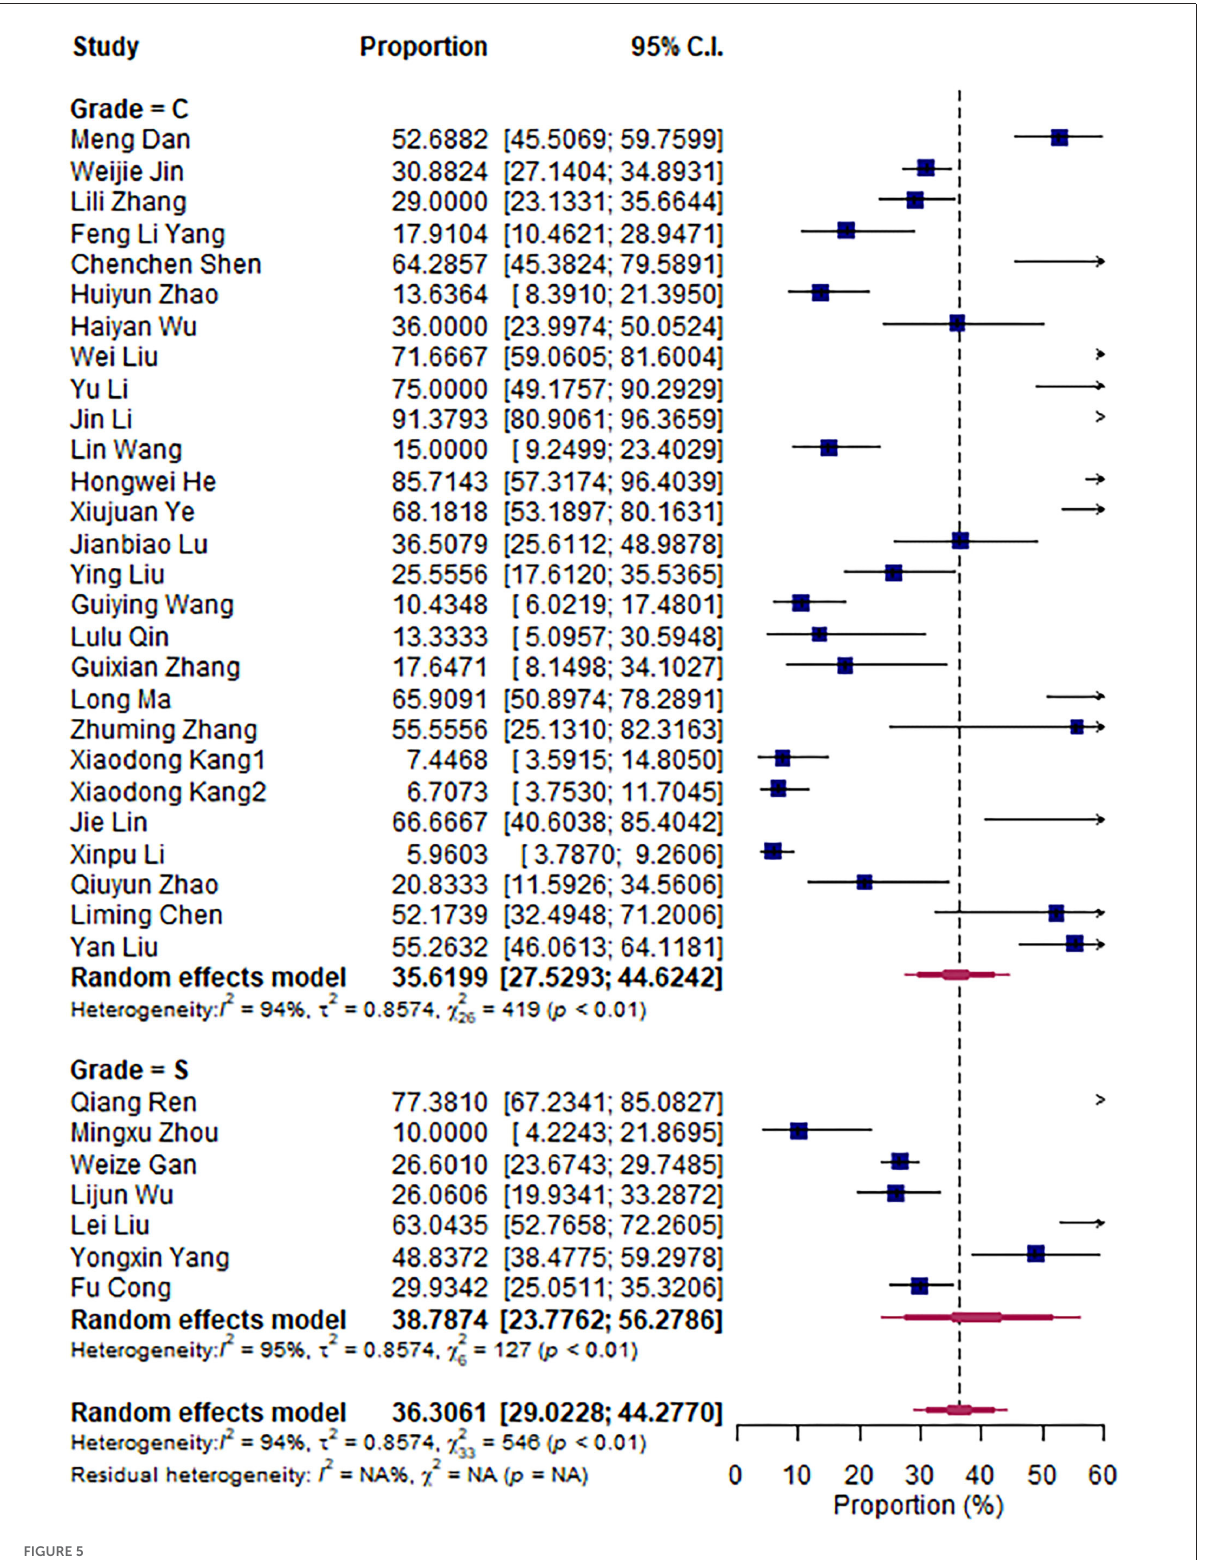
FIGURE5 Overall prevalence subgroup by